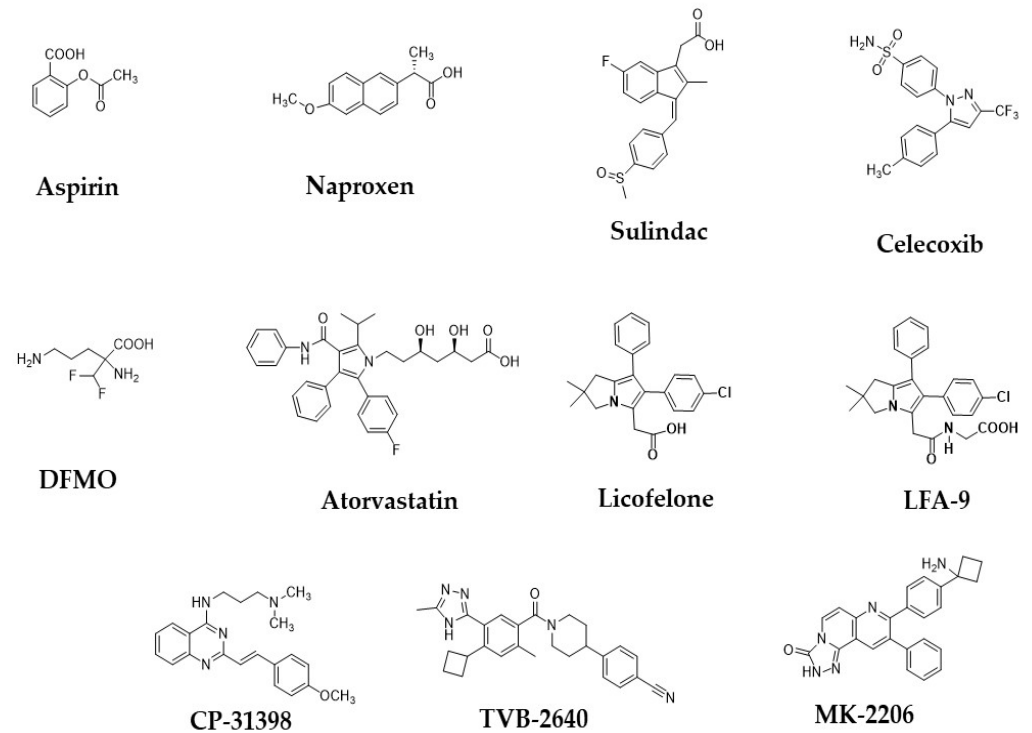
Figure 2. Chemical structures of some of the important precision chemopreventive agents for colorectal cancer prevention and treatment by inhibiting or modulating the various key targets.